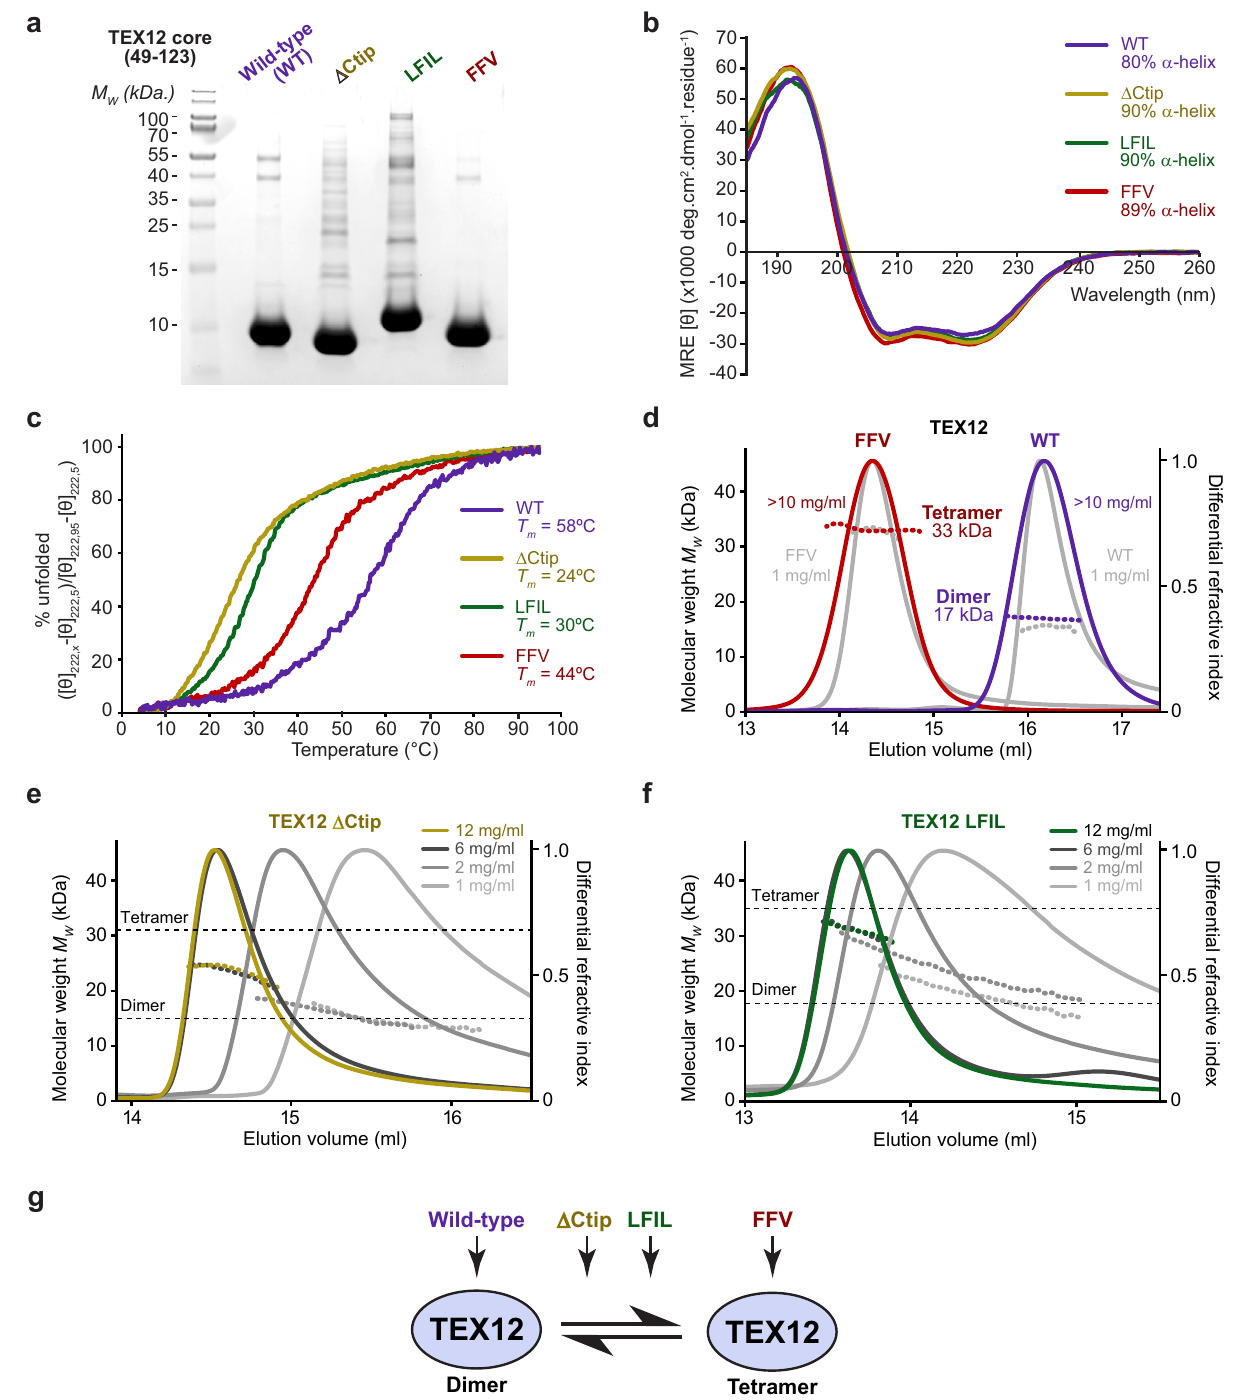
Fig. 2 TEX12 undergoes conformational change from dimer to tetramer upon Ctip mutation. a SDS-PAGE of puri fi ed TEX12 core (amino acids 49 – 123; herein referred to as TEX12) proteins containing wild-type (WT, blue), Δ Ctip (deletion of amino-acids 114 – 123, yellow), LFIL (L110E F114E I117E L121E, green) and FFV (F102A F109E V116A, red) sequences. b , c Circular dichroism (CD) analysis. b Far UV circular dichroism (CD) spectra recorded between 260 and 185nm in mean residue ellipticity, MRE ([ θ ]) (x1000deg.cm 2 .dmol − 1 .residue − 1 ). Data were deconvoluted using the CDSSTR algorithm, with helical content indicated. c CD thermal denaturation recording the CD helical signature at 222nm between 5 and 95°C, as % unfolded. Melting temperatures were determined from the second derivatives of the curves. d – f SEC-MALS analysis in which differential refractive index (dRI; solid lines) is shown with fi tted molecular weights ( M w ; dashed lines) plotted across elution peaks. d TEX12 wild-type (WT) is a 17kDa dimer, whereas the FFV mutant is a 33kDa tetramer (theoretical — 18 and 36kDa); samples were analysed at >10mg/ml (red and blue) and at 1mg/ml (grey). e , f SEC-MALS analysis of TEX12 ( e ) Δ Ctip and ( f ) LFIL mutants at concentrations between 1 and 12mg/ml (as shown), indicating concentration-dependent dissociation of species intermediate between the theoretical masses of dimers and tetramers ( Δ Ctip — 16 and 32kDa; LFIL — 18 and 36kDa). g TEX12 is a dimer that undergoes conformational change into a tetramer by FFV mutation, and forms a mixture of less stable species, in equilibrium between dimer and tetramer, upon Δ Ctip and LFIL